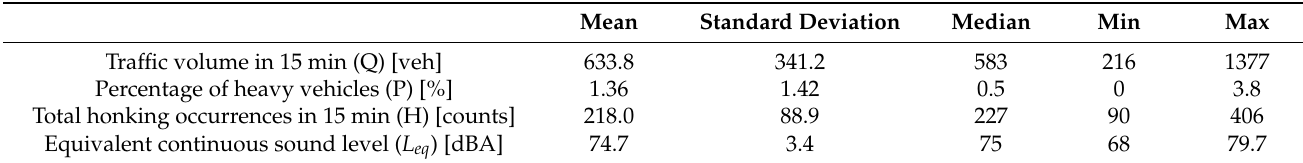
Figure 2. Localization of the identified sites, respectively site 1 ( a ), site 2 ( b ), site 3 and 4 ( c ), site 5 ( d ). Table 1. Resume of the main statistics of data and parameters used in the calibration and testing of the models. All the features have been measured with 15 min time span.